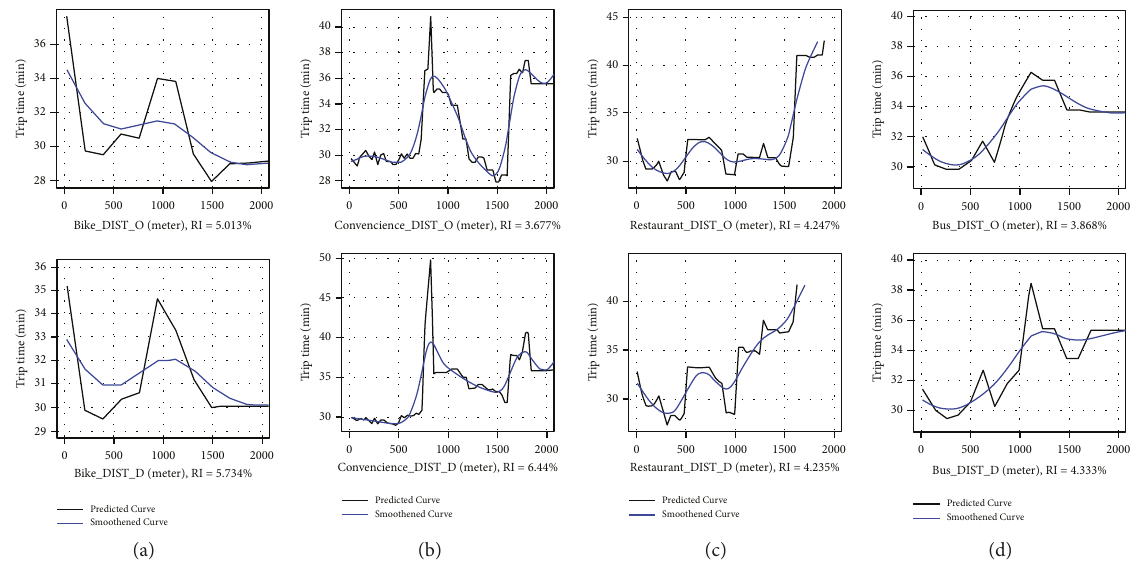
Figure 4: The effects of built environment on trip time (the top four variables of